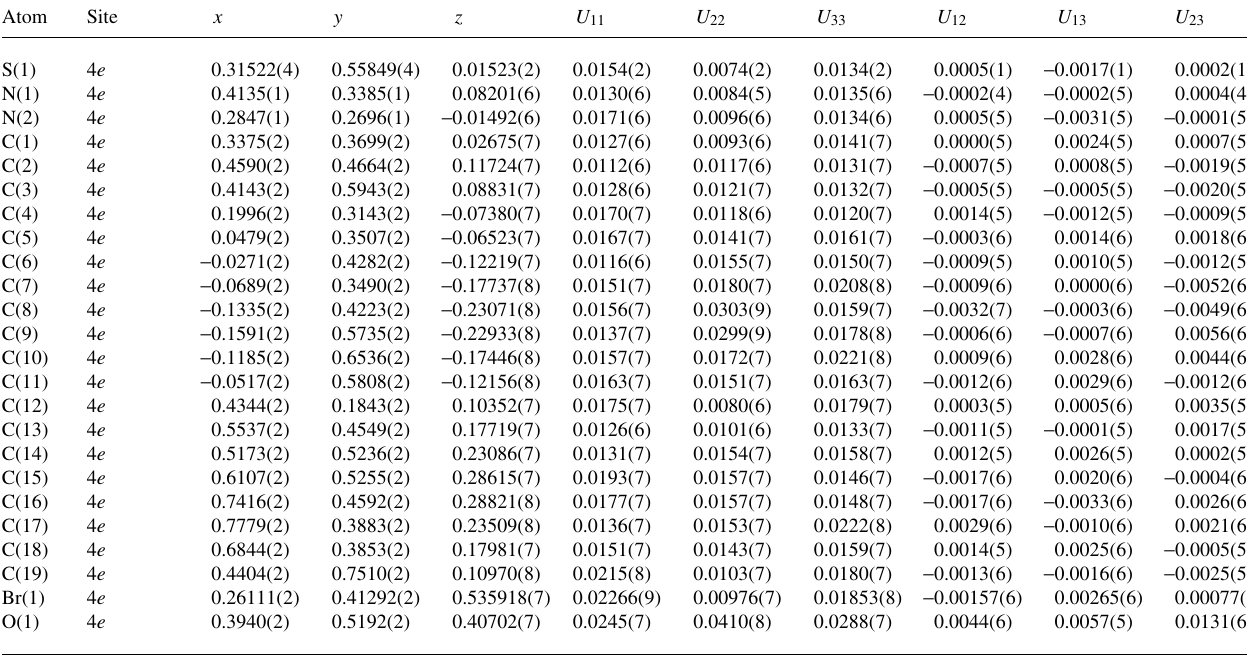
Table 3. Atomic coordinates and displacement parameters (in Å 2 ) .